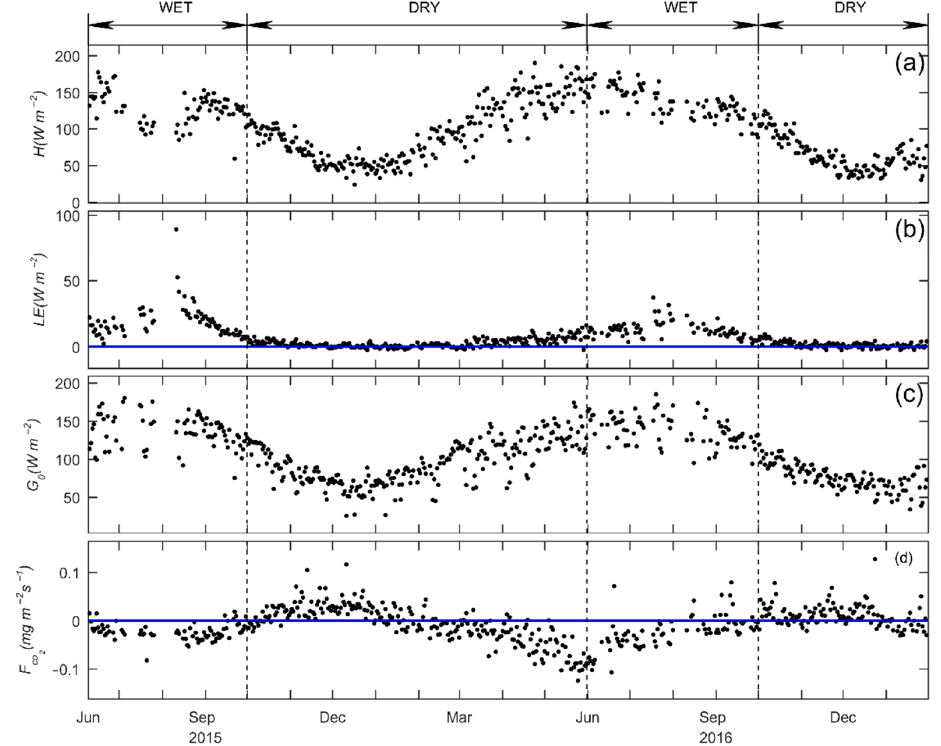
Figure 6. Daily daytime (10:00 – 19:00 local time) means of ( a ) sensible heat flux ( H in W m − 2 ), ( b ) latent heat flux ( LE in W m − 2 ), ( c ) soil heat flux ( G 0 in W m − 2 ), and ( d ) CO 2 flux ( F CO